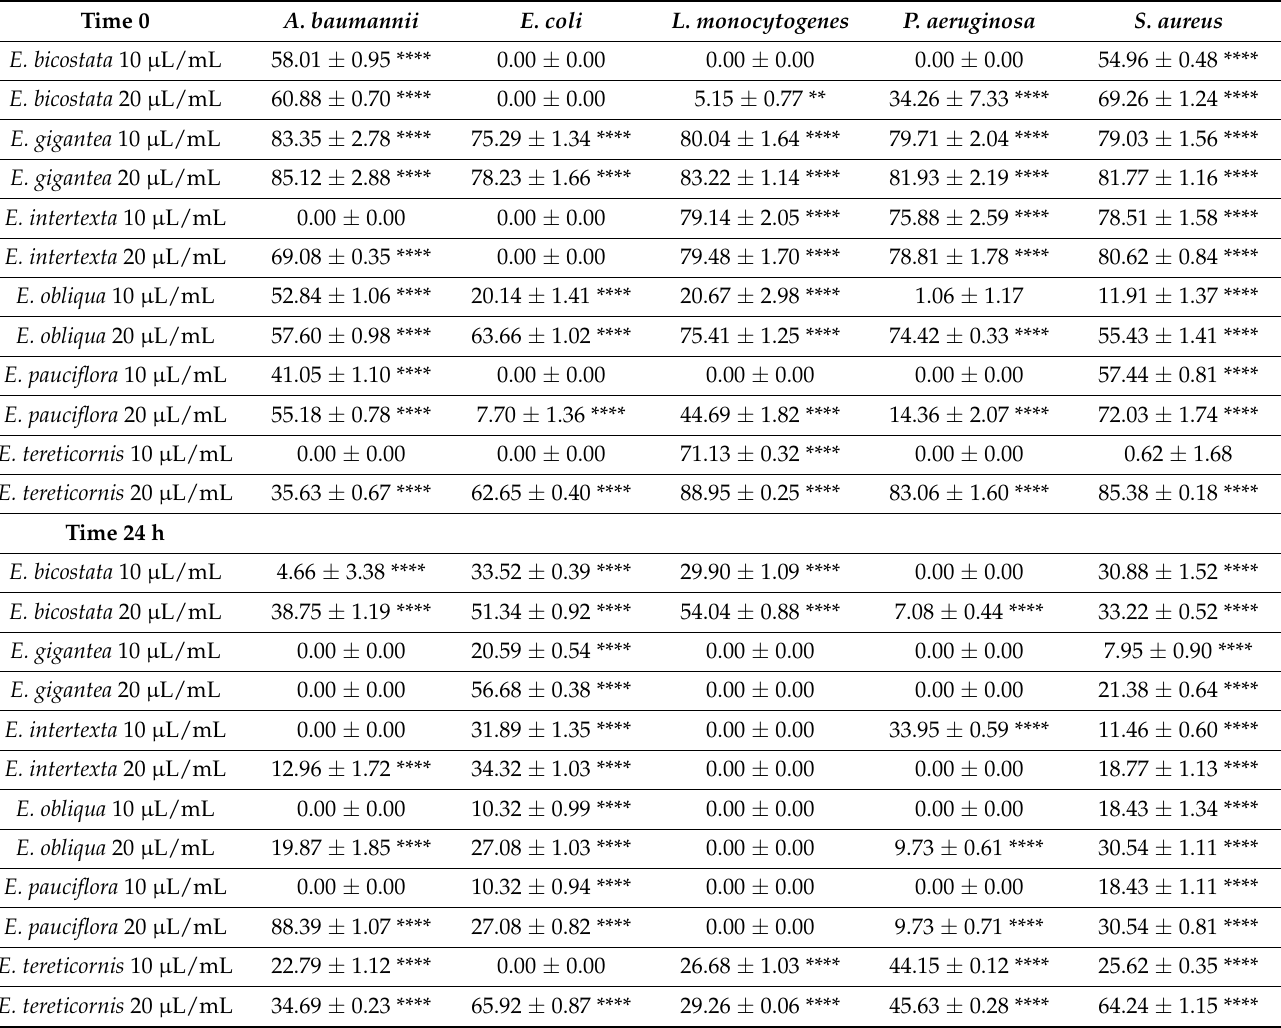
Table 7. Percent inhibition of two doses of the EOs on biofilm metabolic activity of A. baumannii , E. coli , L. monocytogenes, P. aeruginosa , and S. aureus at 0 and 24